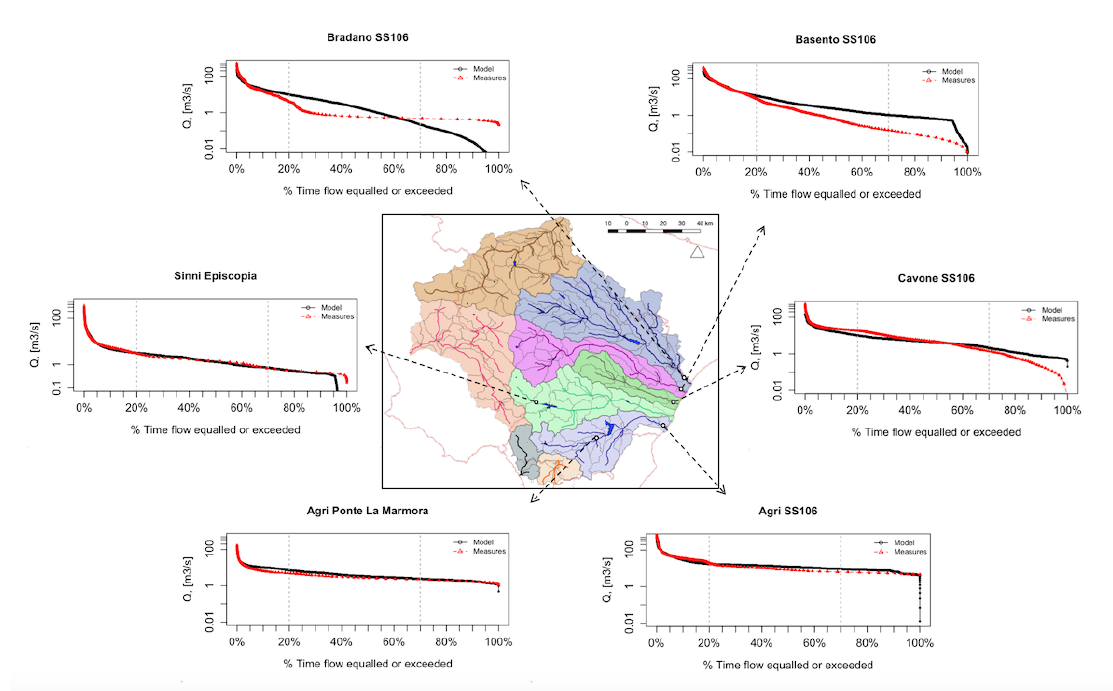
Figure 6. Flow duration curves obtained for each of the six investigated stream gauges: measured discharge (red line) versus modeled discharge obtained using the embedded reservoir model (black line). The model was calibrated against two years of discharge to maximize the exploitation of available